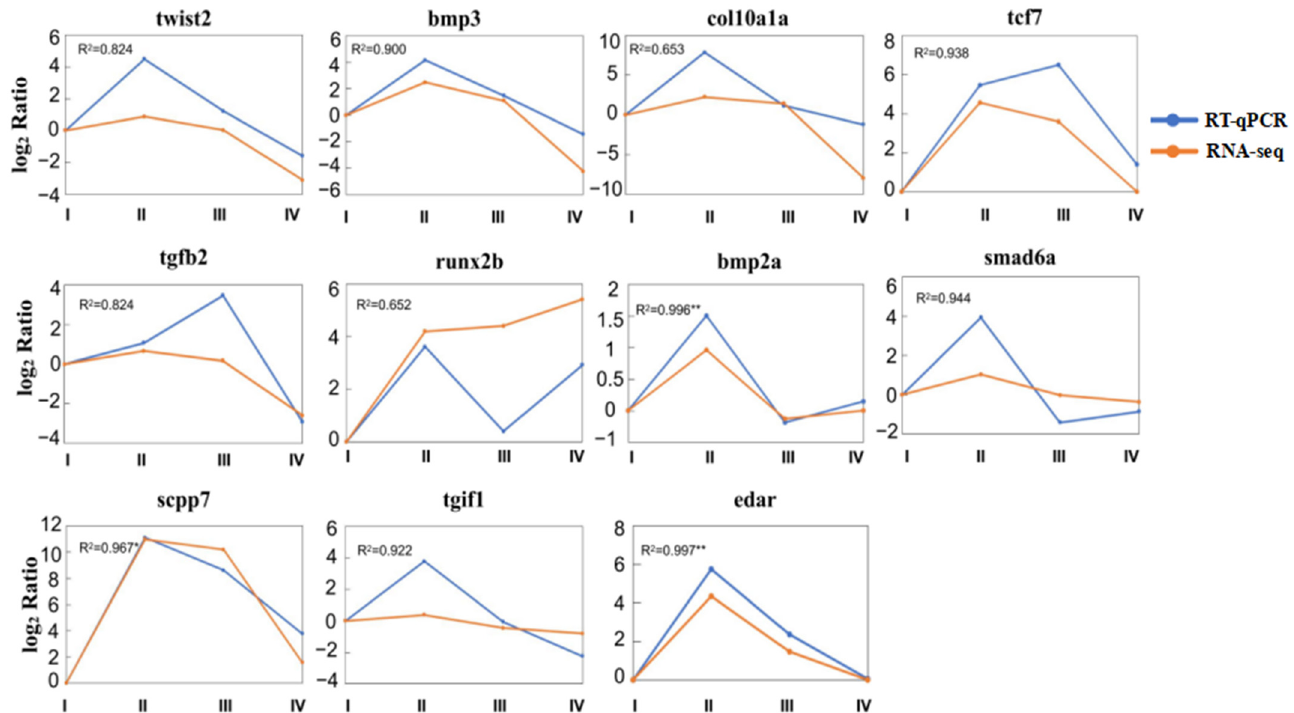
Figure 6. The comparison of the selected gene expression patterns in RT-qPCR and RNA-seq showed a high correlation between the two methods. The calculation and mapping of the log 2 ratio of expression changes in the other three stages was relative to the first stage (the log 2 ratio of stage I was set to 0). The blue line shows the RT-qPCR results and the orange line shows the RNA sequence results. The Pearson correlation coefficient ( R 2 ) was used to measure the correlation between RT- qPCR and RNA-seq results. The results were analyzed by t -test. * indicates significant correlation ( p < 0.05) while ** indicates highly significant correlation ( p <